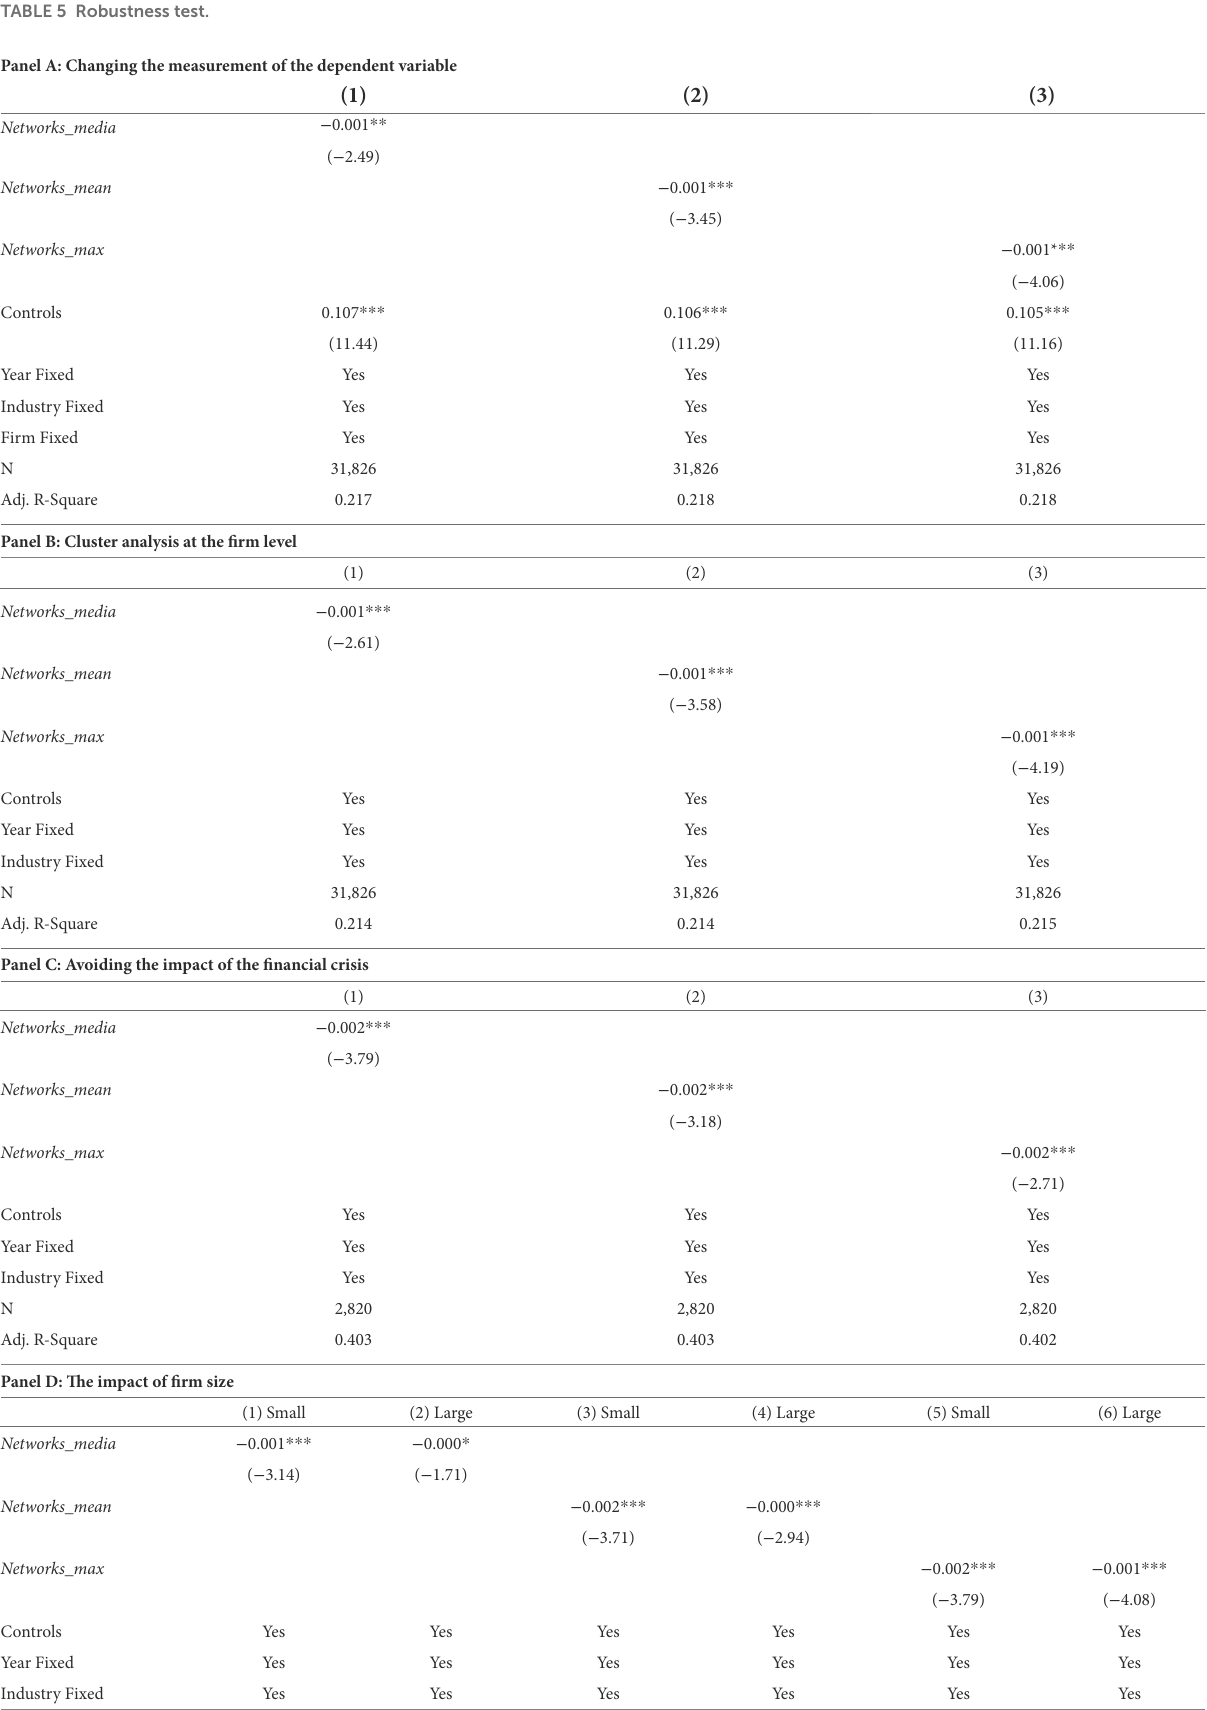
TABLE 5 Robustness